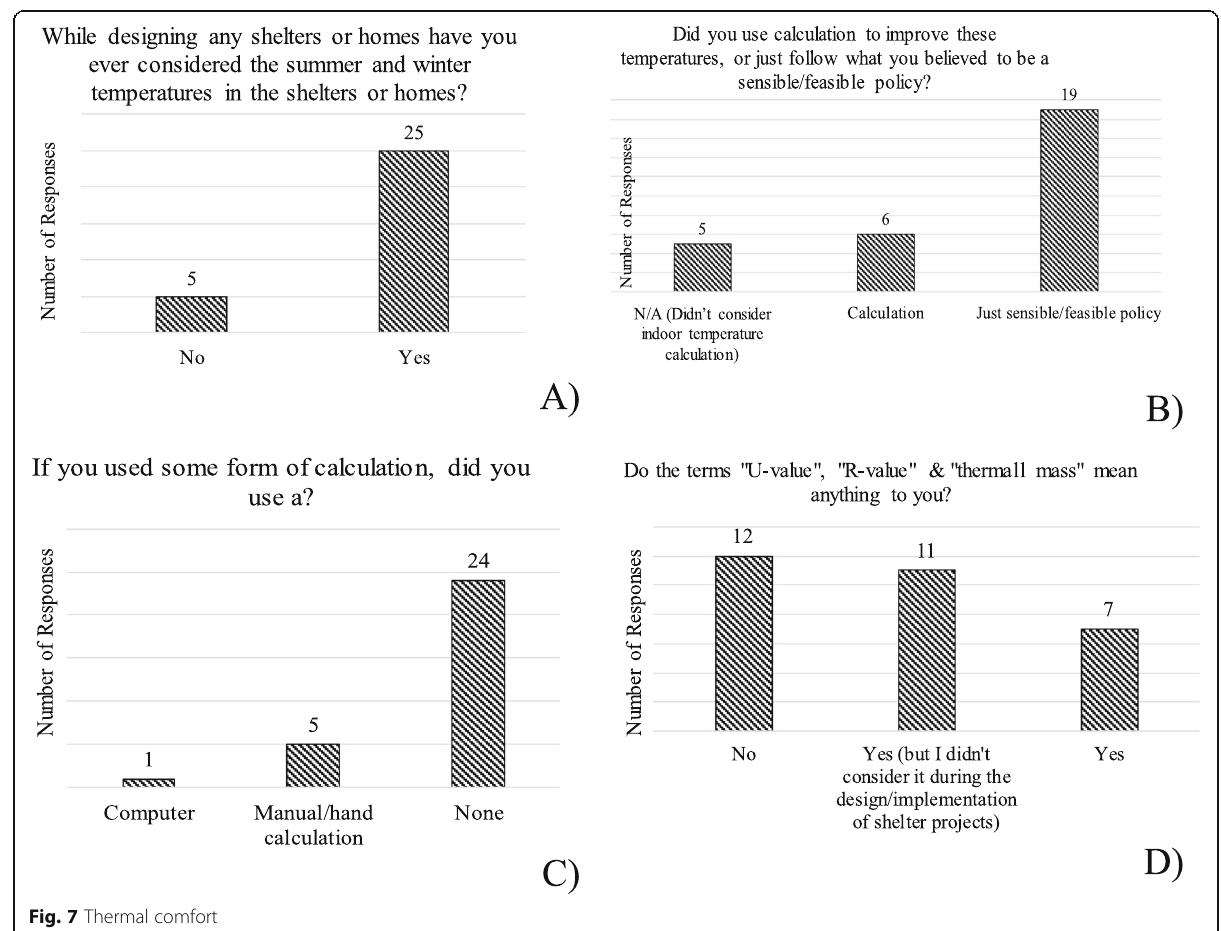
participants who considered the amount of energy needed in shelters used the ‘ sensible/feasible ’ ap- proach. Only three participants reported performing some sort of calculation (see Fig. 8e); two of them used a manual method and only one used a com- puter, but no particular energy simulation software or computation tools were mentioned (see Fig. 8f). Figure 9 details the responses on shading technologies and strategies practised by the aid workers, showing that the majority used a ‘ sensible/feasible ’ approach to establish the size or design of shading in shelters.